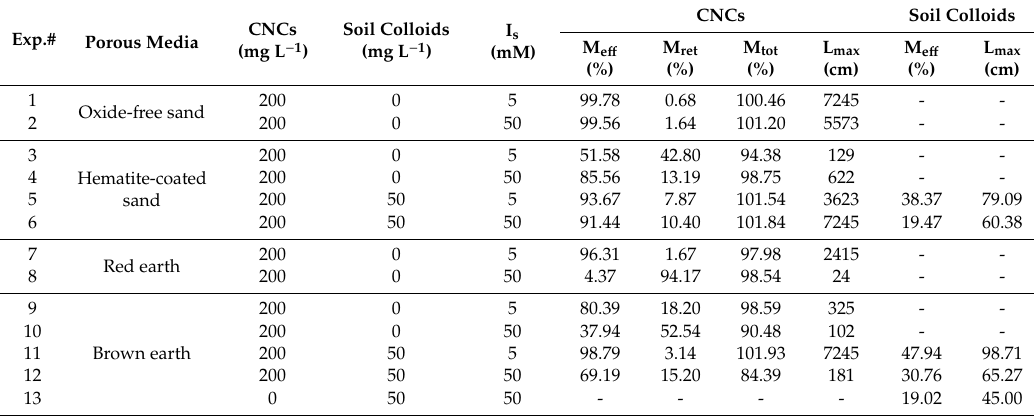
Table 2. Mass recoveries of CNCs and soil colloids during the transport